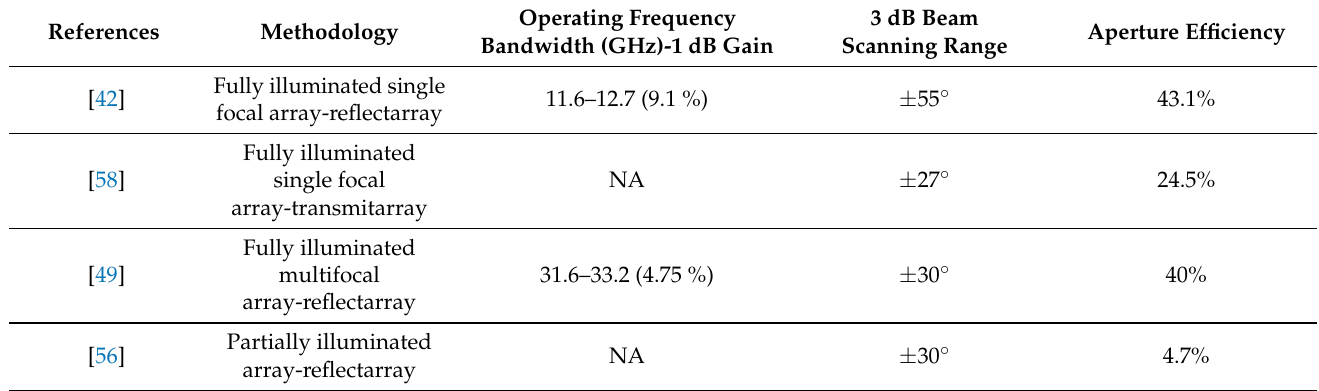
Table 3. Comparative analysis of reconfigurable RAs using feed